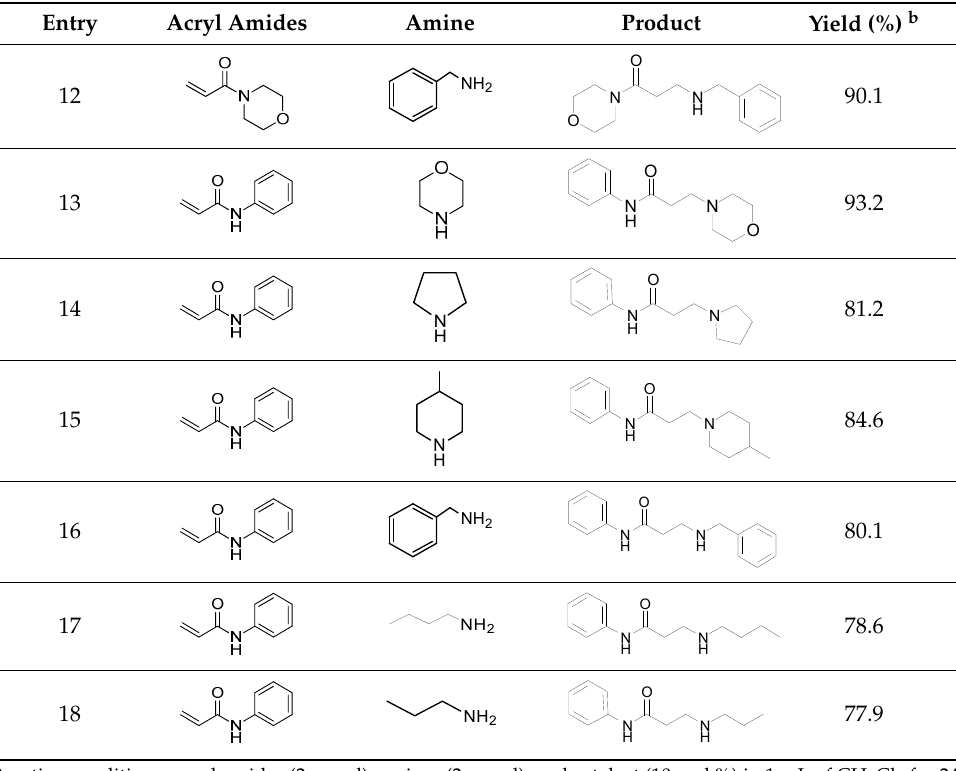
mechanism for Fe 3 O